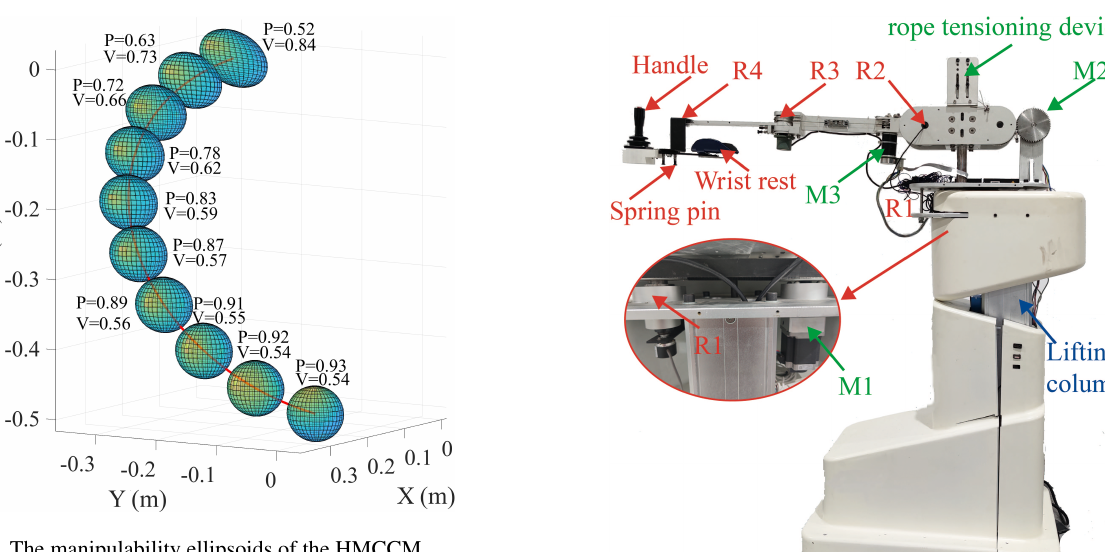
Figure 4. The manipulability ellipsoids of the HMCCM.